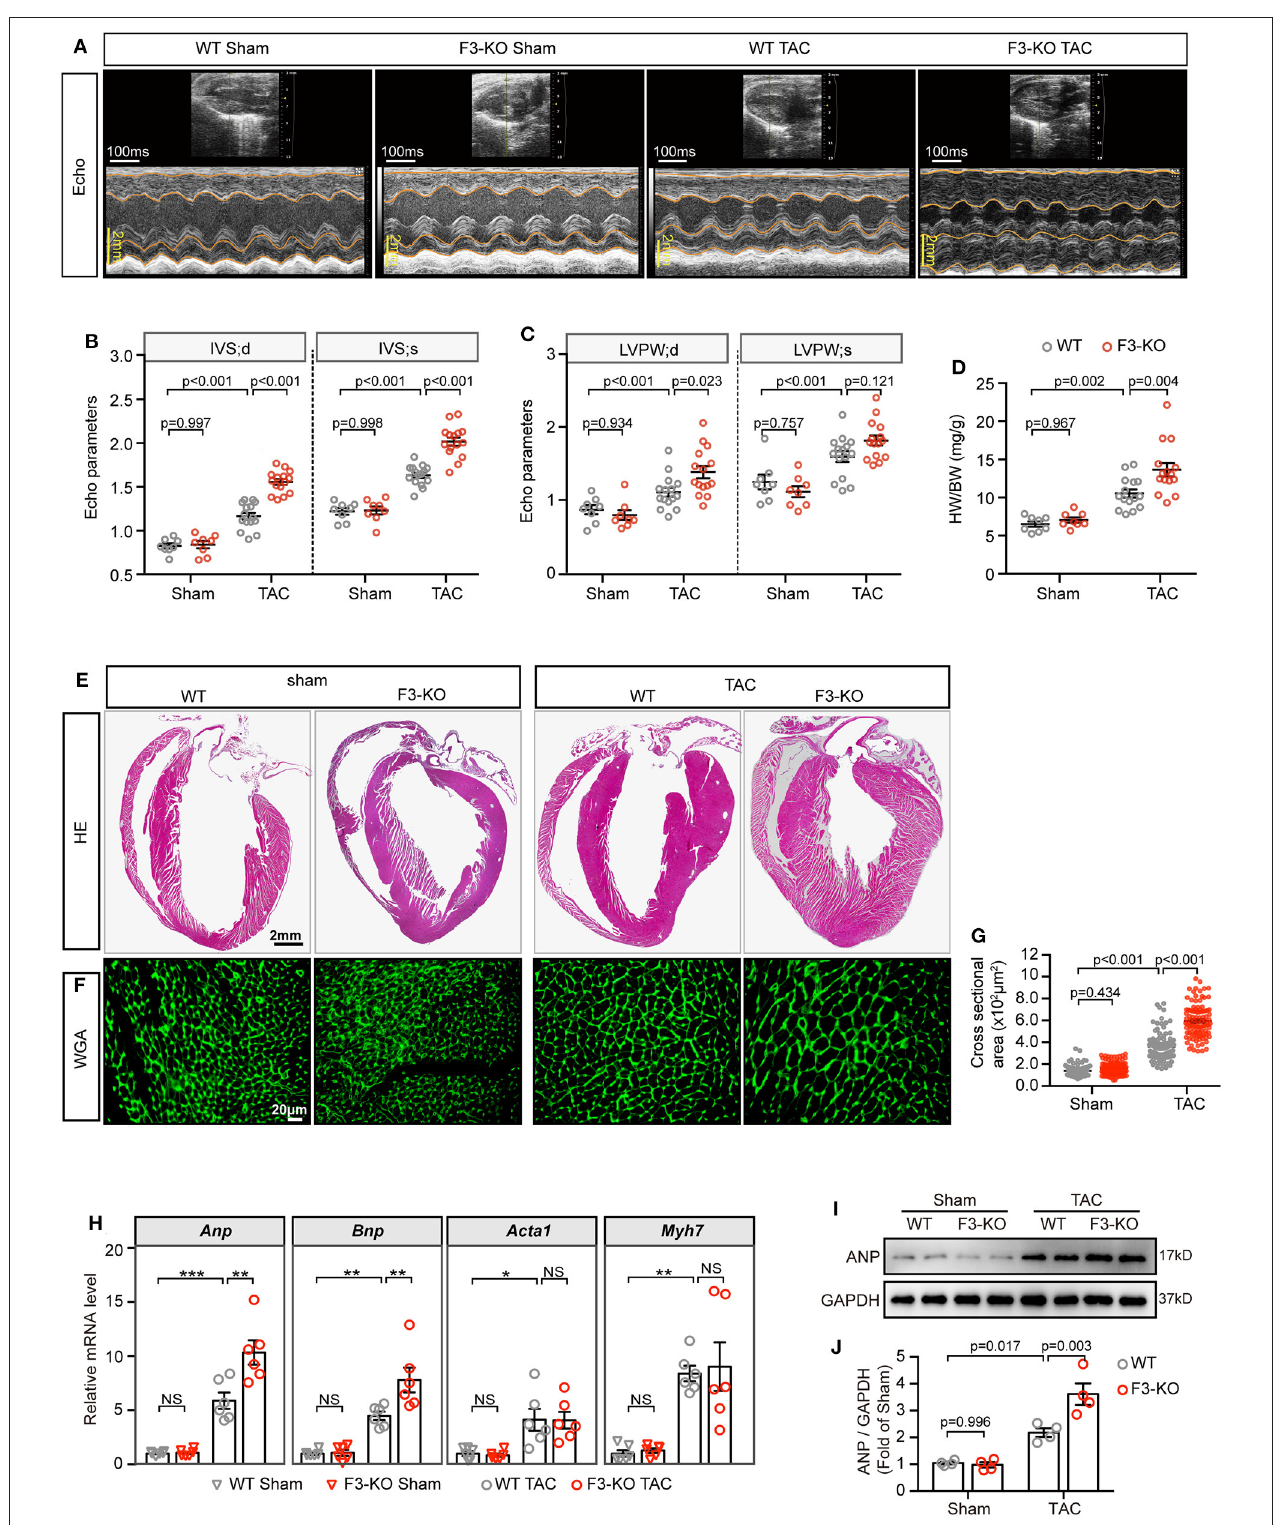
FIGURE 2 | Deficiency of FABP3 aggravates TAC-induced cardiac hypertrophy. (A) Representative echo images of the WT and F3-KO mice at 4 weeks after TAC or sham operation. (B) Quantification results for the interventricular septum (IVS) in (A) . (C) Quantification results for the left ventricular posterior wall thickness